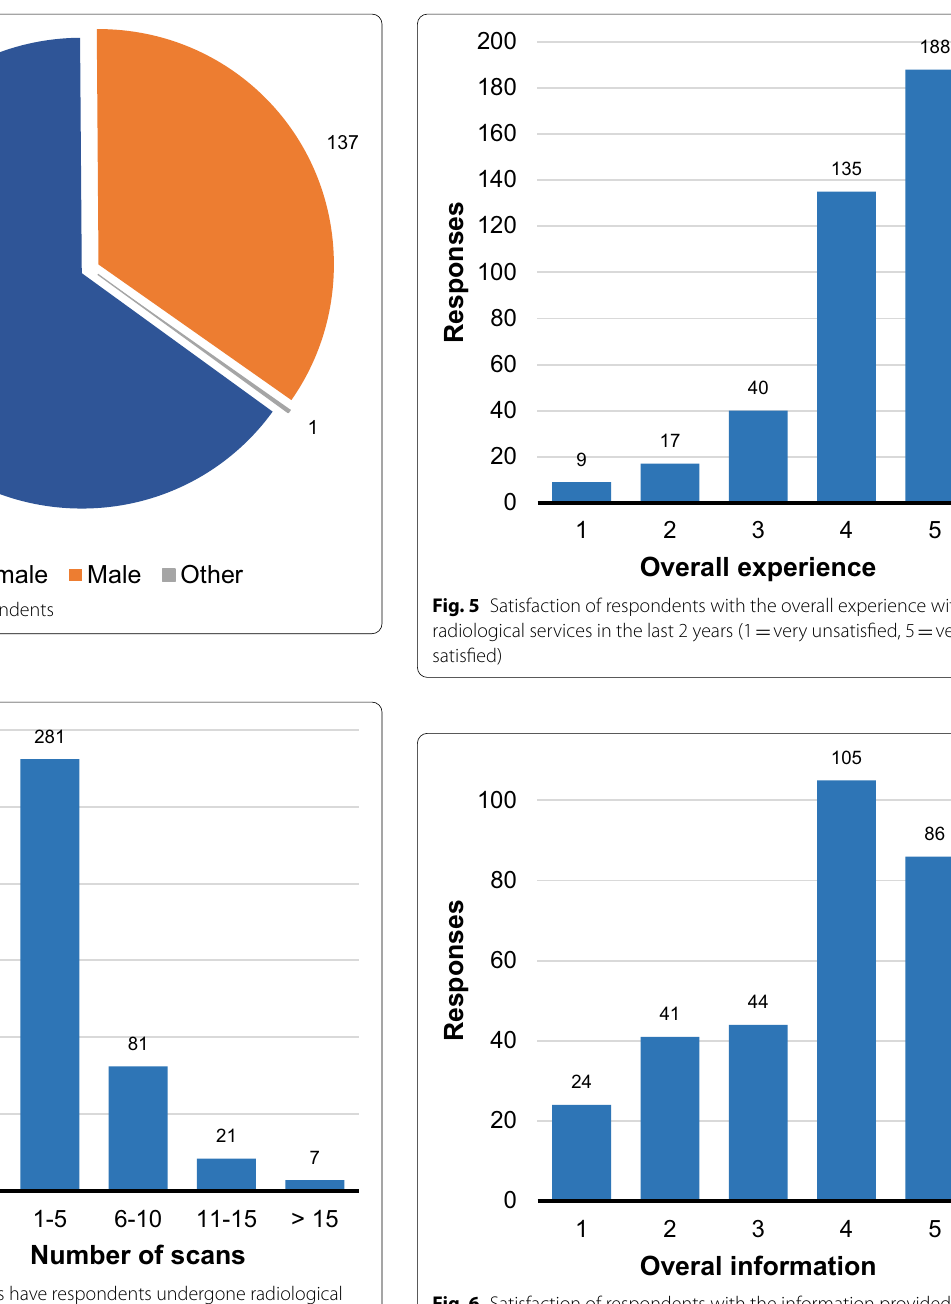
Fig. 6 Satisfaction of respondents with the information provided about the procedure, e.g.risks, benefits, description of how it is performed (1 very unsatisfied, 5 very = =